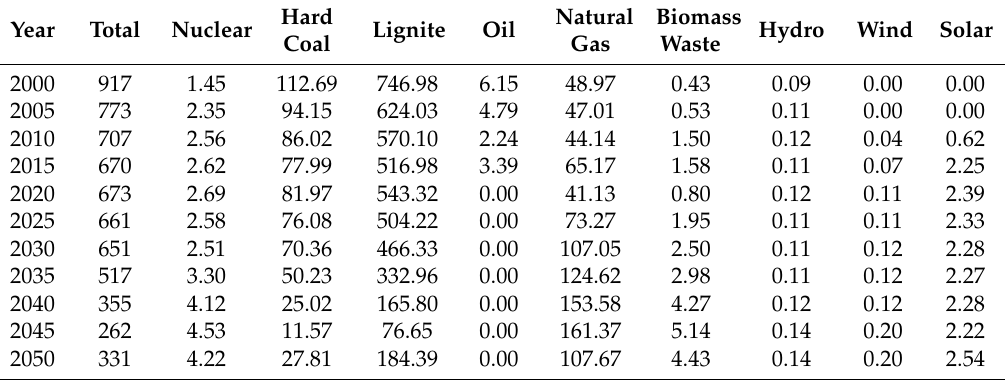
Figure 4. Analysis of greenhouse gas emissions of electricity production in the Czech Republic based on Intergovernmental Panel on Climate Change (IPCC) method. Table 1. Greenhouse gas emission electricity production from individual energy sources in the Czech Republic in kg CO 2 eq.